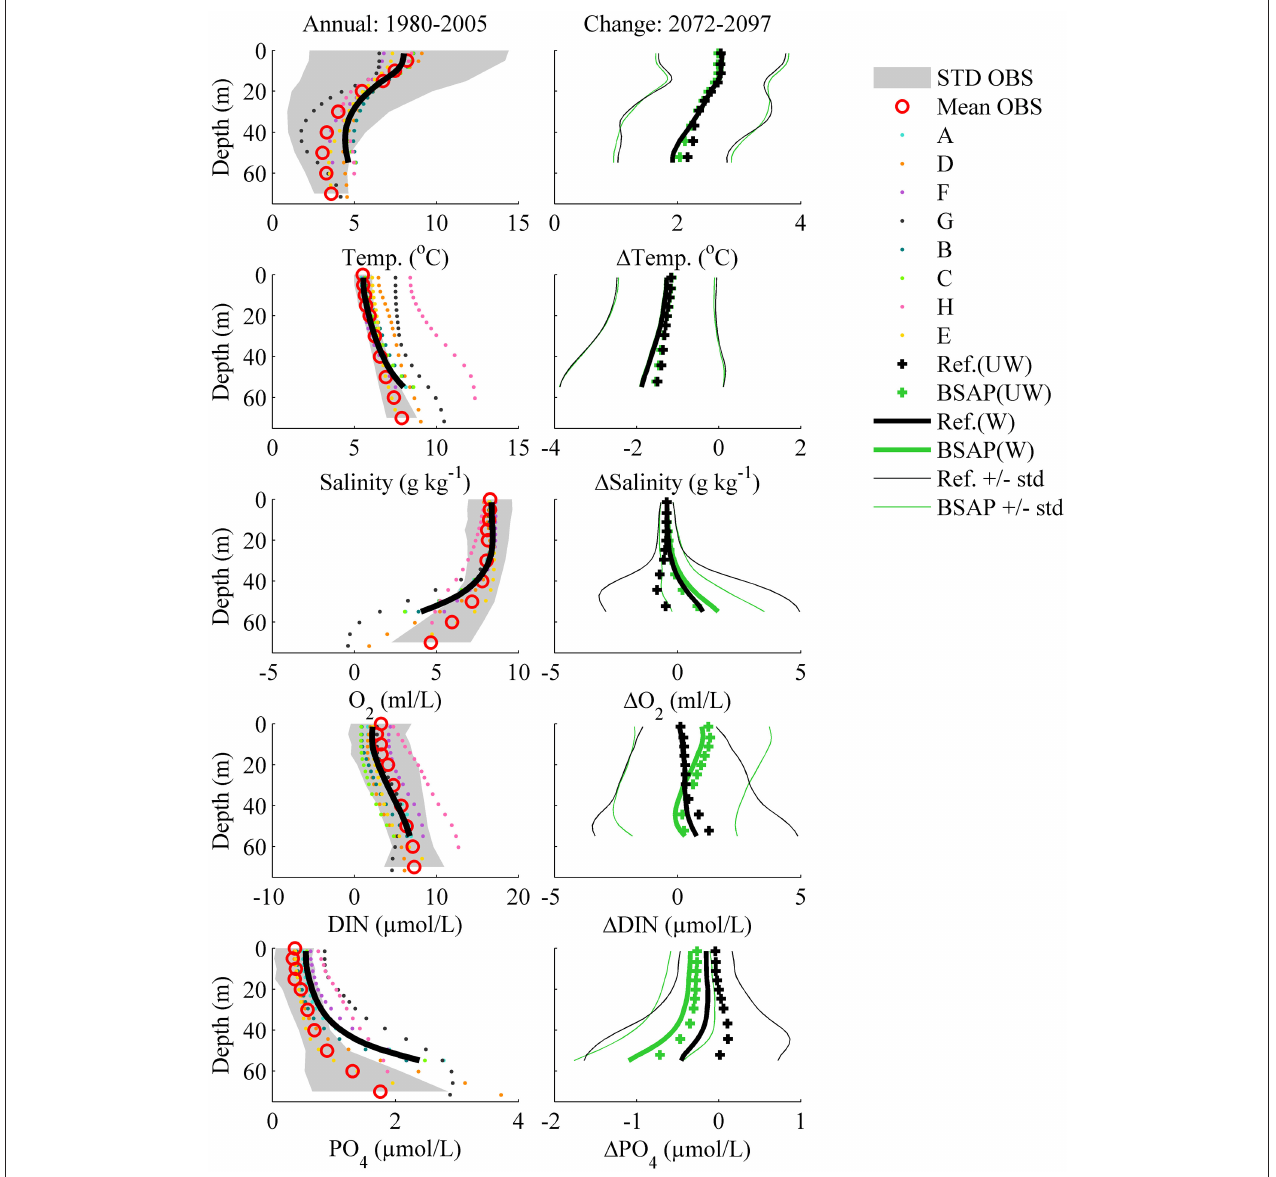
FIGURE 11 | Mean observed and simulated profiles in the control runs for each variable and each Model A to H at LL07 in the Gulf of Finland for the period 1980–2005 (left panels). The ensemble mean value (thick black line) is calculated from the weighted model results. In addition, the unweighted (plus signs) and weighted (thick solid lines) ensemble mean changes and standard deviations between the future (2072–2097) and present (1980–2005) climates in REF and BSAP scenario simulations are shown (right panels). Standard deviations are calculated from the two ensembles without